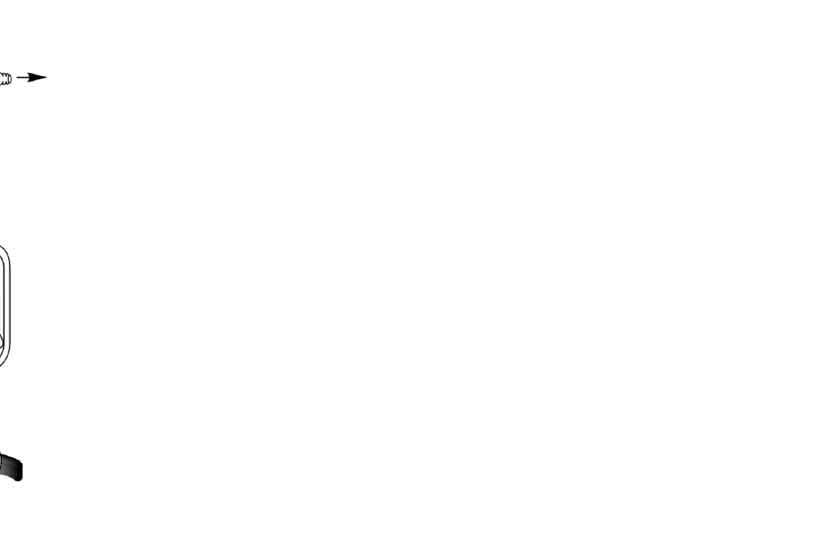
Figure 5. Schematic representation of organic solvent extraction using the Soxhlet method.